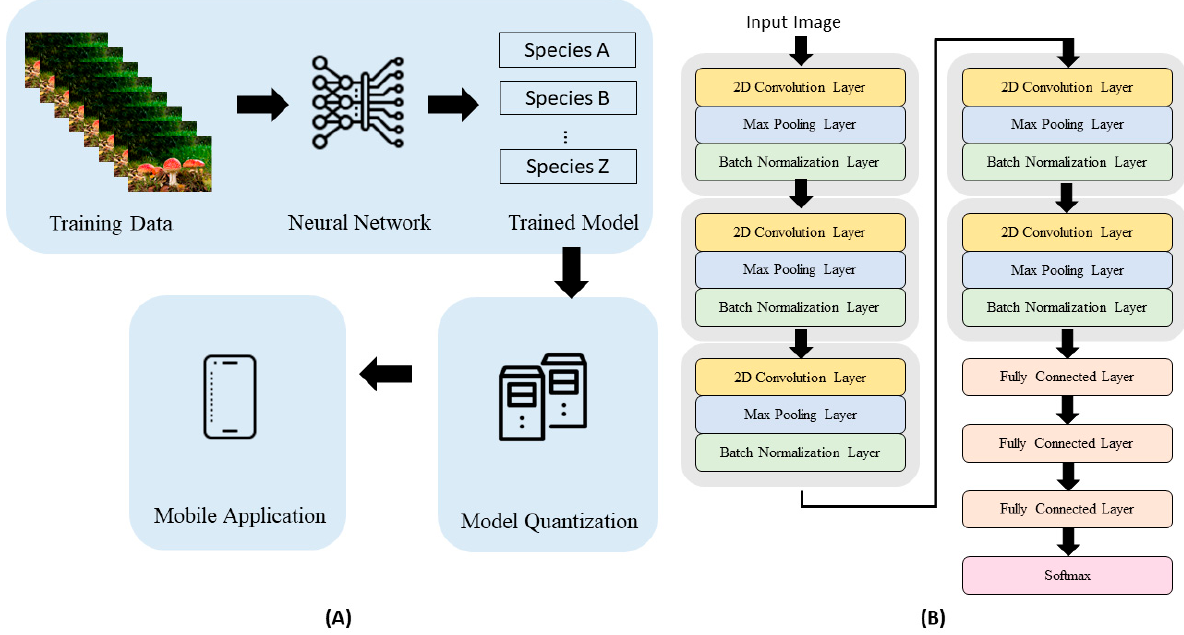
Figure 1. Conceptual diagram explaining the machine-learning-based mushroom image classifica- tion. ( A ) Shows the input images to output layers which are generated from a server. Once the training model is verified, it is transferred to a smartphone device. ( B ) Series of layers starting from 224 (H) × 224 (W) × 3 (channels) and subsequent convolution of 2 × 2. The image is flattened as a one-dimensional array of 4500 elements and fed to a feed-forward neural network. This network is subsequently reduced to 300, 300, and 3 neurons of fully connected layers corresponding to the number of classes.